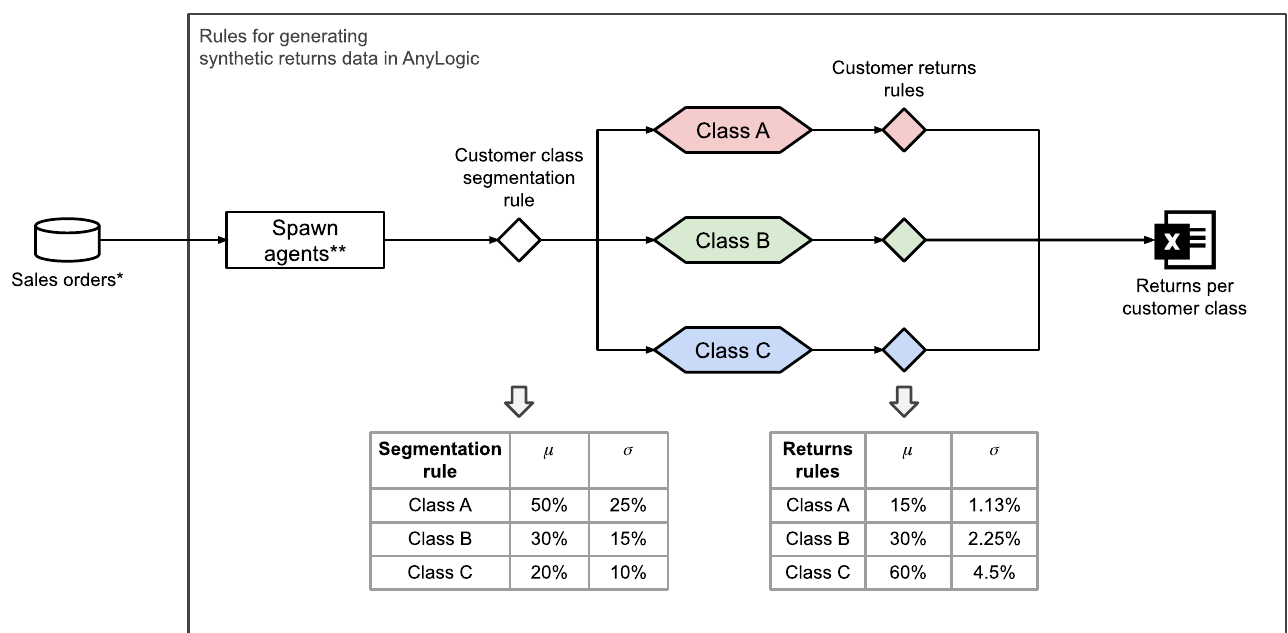
Figure 2. Dataset generation for product returns.